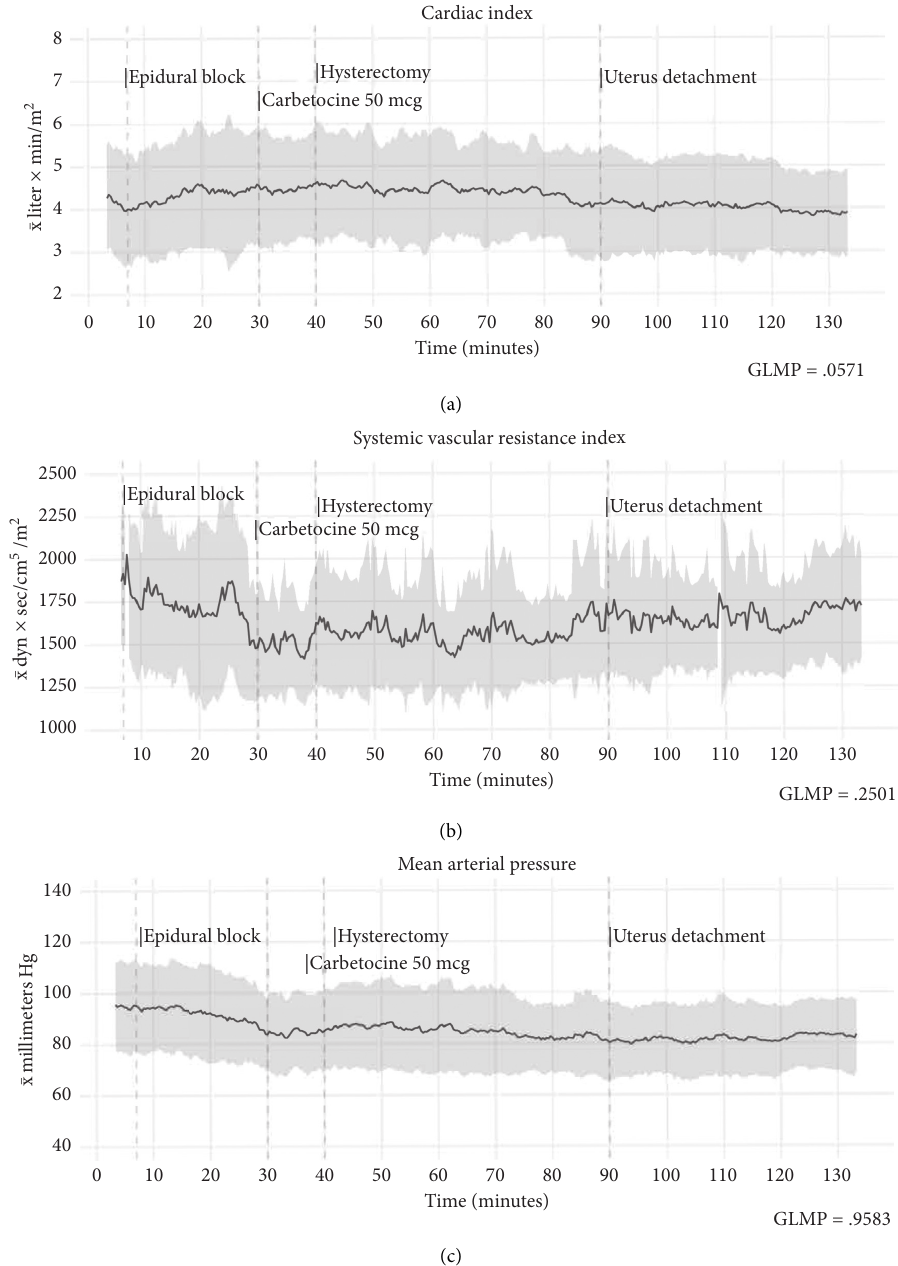
Figure 1: Hemodynamic trends (x ̄ , bold black line; σ , gray zone). Cardiac index (a) initially showed a mild hyperdynamic pattern, followed by an increase due to the epidural block, and it remained relatively stable during the surgery, with inferior values at the end when compared with the first ones. The systemic vascular resistance index (b) decreased after the epidural block. However, these fluctuations were maintained with minimal variance despite the bleeding. Mean arterial pressure (c) showed less variation and did not exhibit the changes recorded in the vascular resistance